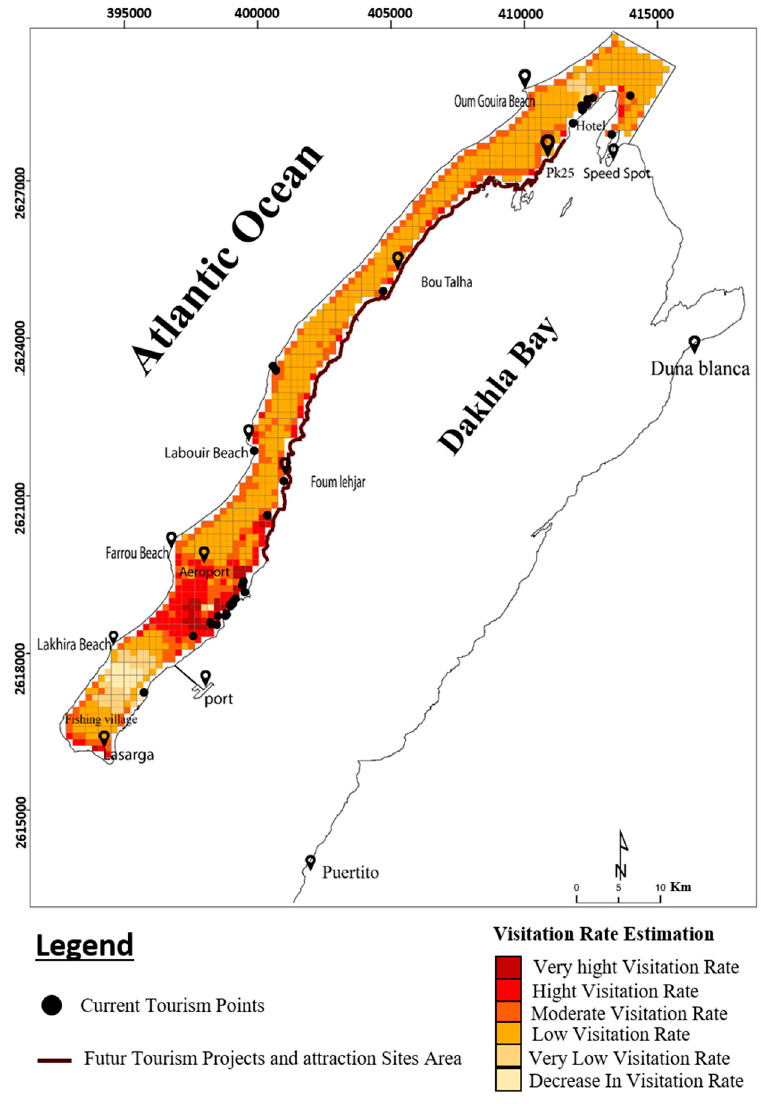
Figure 7. Annual visit rate estimation across Dakhla Bay.